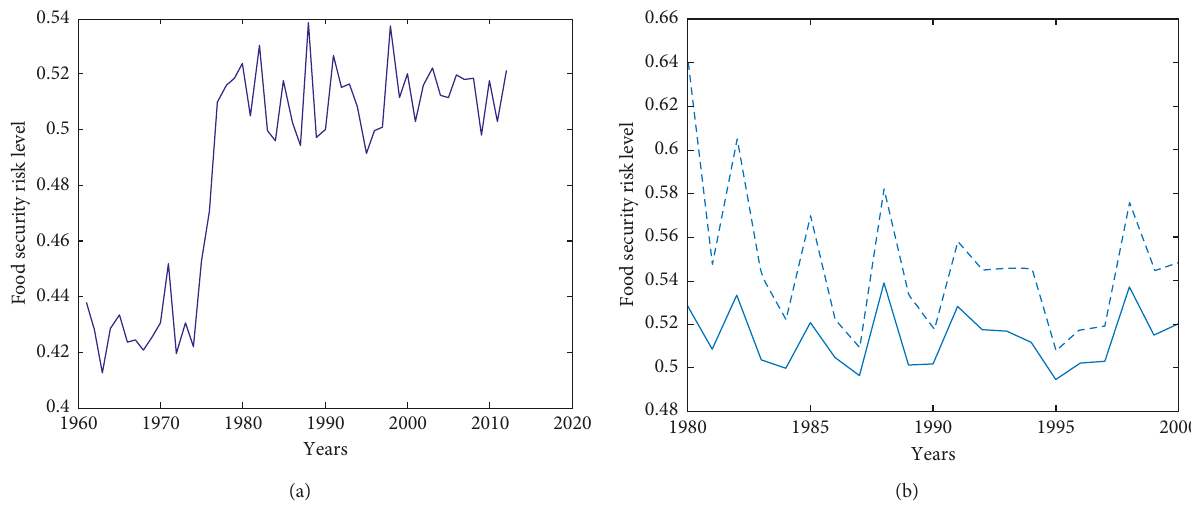
Figure 5: The plots of food security risk level: (a) Z- number-based fuzzy system for the years 1961–2013, (b) comparisons of simulation results of the conventional type-1 fuzzy system (dashed line), and Z- number-based fuzzy system (solid line) for the years 1980–2000.